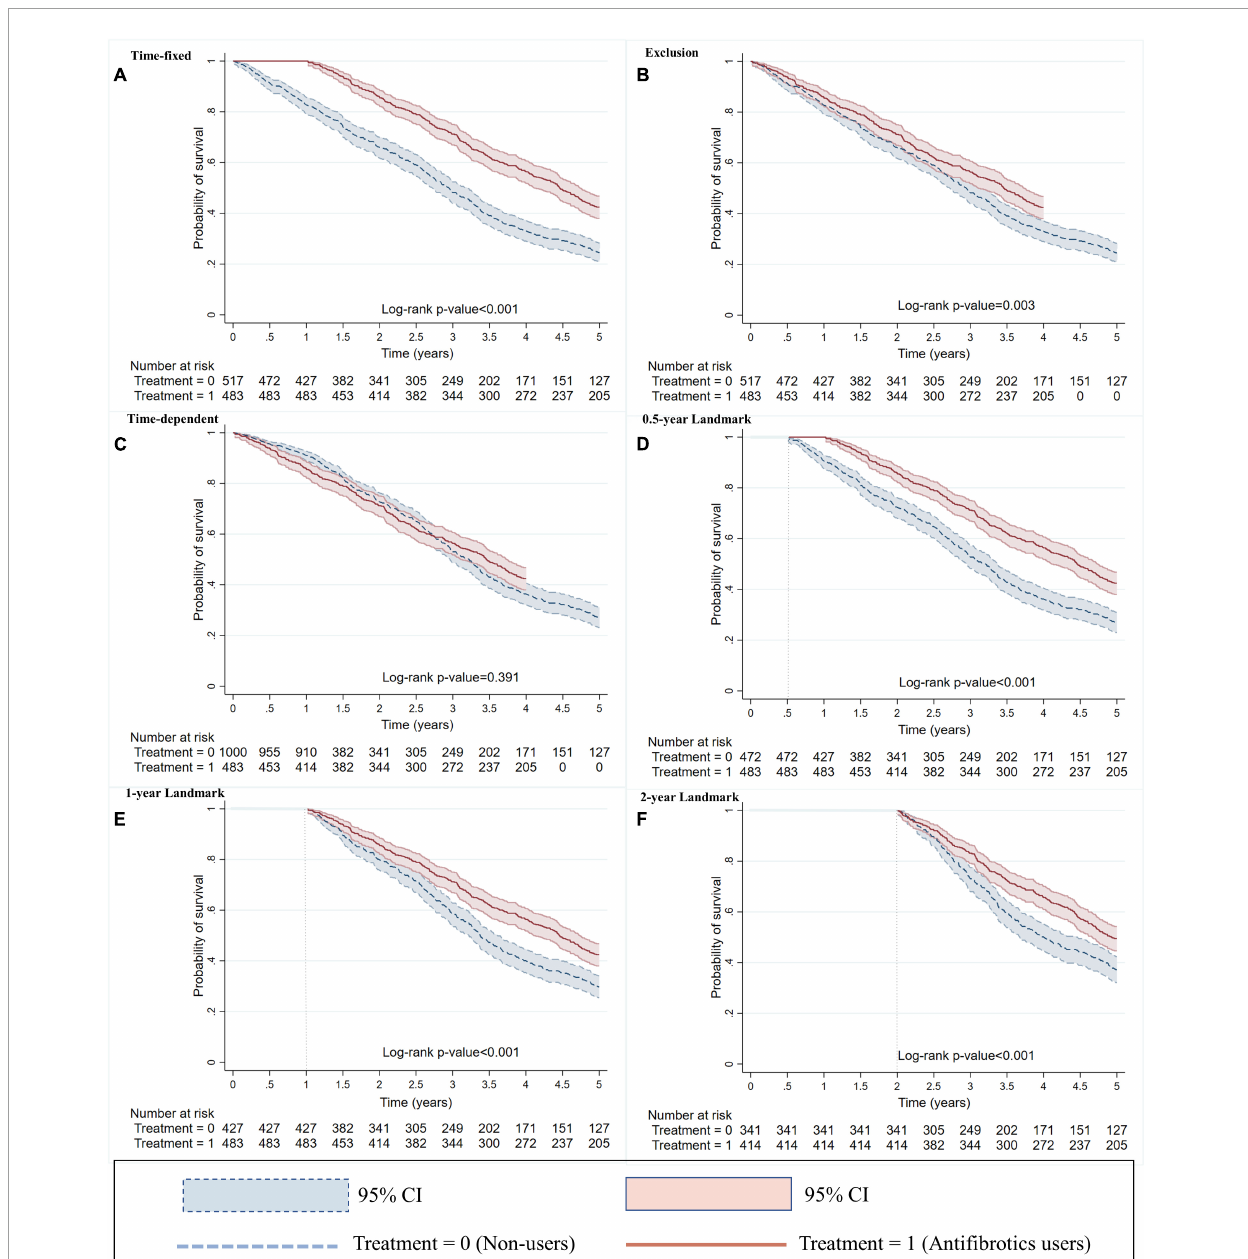
FIGURE2 Kaplan–Meier survival curves with methods of (A) time–fixed, (B) exclusion, (C) time–dependent, and (D–F) landmark. For the time–fixed method, the immortal time was ignored and incorporated in the treated group. For the exclusion method, the immortal time was excluded from the study. For the time–dependent method, the immortal time was switched into the control group, with an additional 483 subjects being added into the control group. For the landmark method, 0.5, 1, and 2 years landmarks excluded 45, 90, and 245 simulated subjects who had died prior to this time point, respectively. Immortal time was defined as the time from cohort entry to the initiation of antifibrotic therapy. Landmark time was defined as a fixed time point, which was the same for all